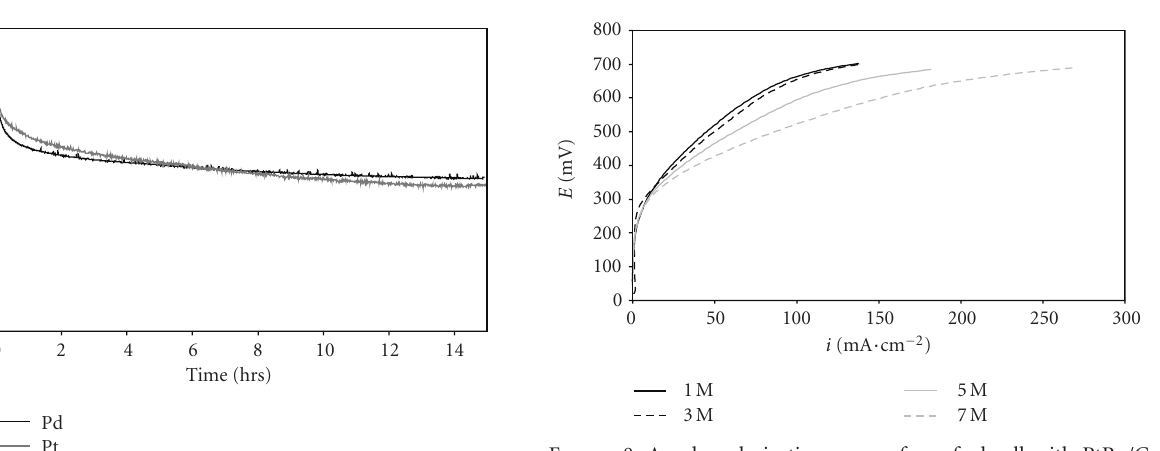
Figure 8: Anode polarization curves for a fuel cell with PtRu/C from E-tek anode catalyst and Pd/C cathode catalyst at 60 ◦ C fed with methanol 1, 3, 5, and 7M with air